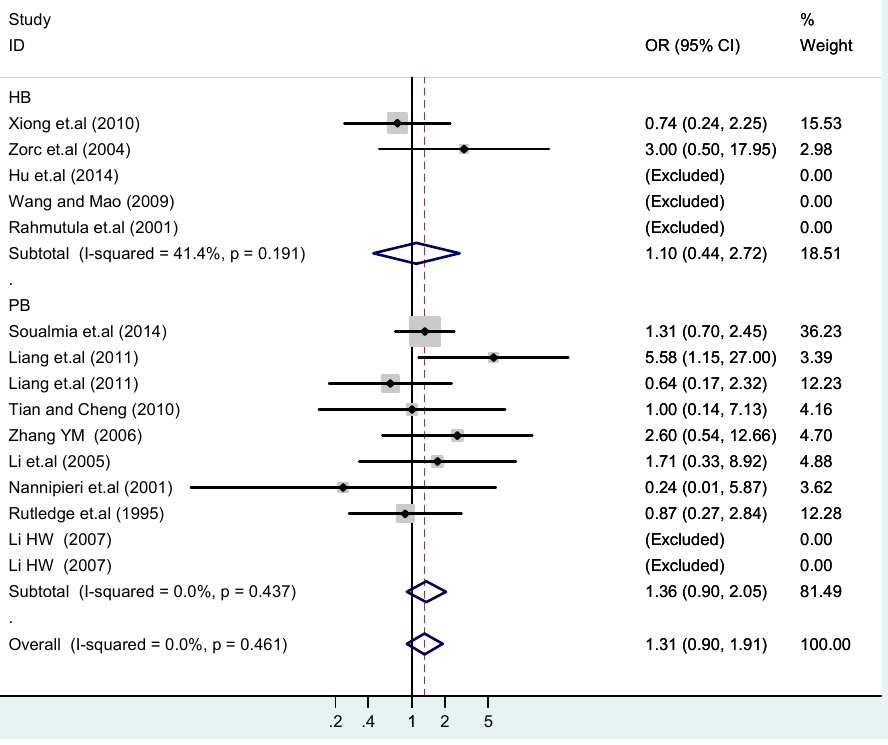
Figure 16. Subgroups in sources of controls of T2238C co-dominant model-2 (CC vs. TT).